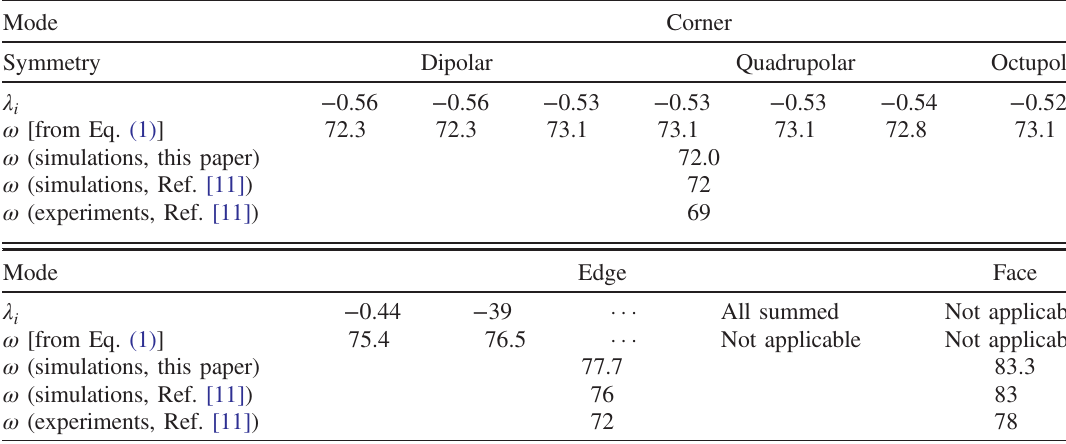
TABLE III. Comparison between energy values for the MgO nanocube modes calculated with Eq. (1), from retarded simulations with experimental dielectric constant found in Ref. [22], from retarded simulation in Ref. [11], and from experimental results from Ref. [11]. Inputs for Eq. (1) are ω [22]. Energies are given in meV. Note the apparent discrepancy for the face mode values between simulations and experiments, proven in Ref. [11] to be an effect of finite spectral resolution in the